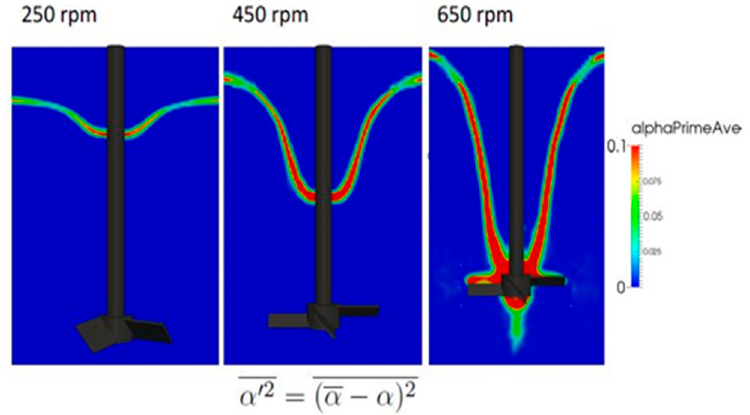
Figure 6. Predicted amplitudes of vortex surface oscillations.